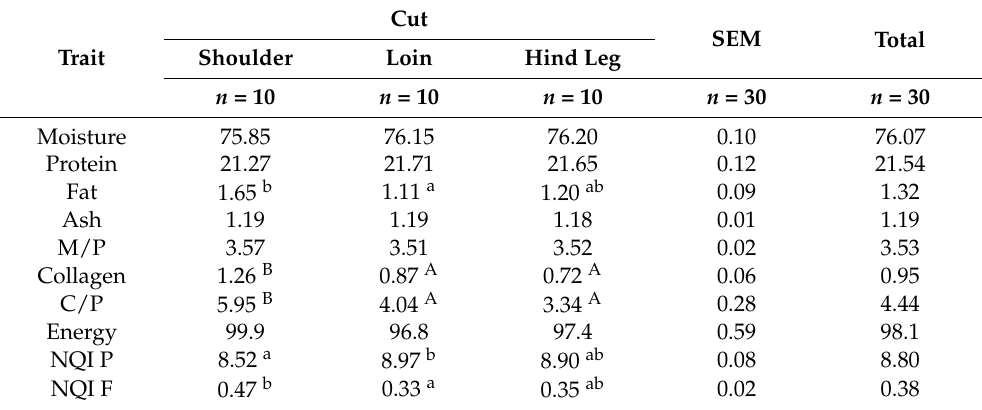
Table 1. Proximate composition (%), energy value (kcal) and nutritional quality indexes (NQI) of beaver raw muscle tissue (mean ± standard error).